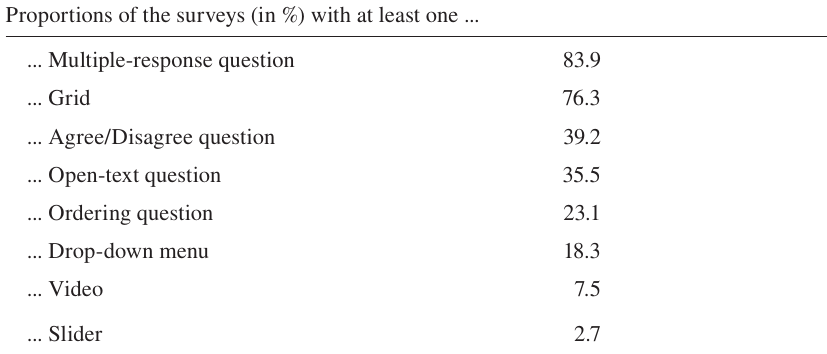
Table 5 Proportions of surveys including different questions formats Proportions of the surveys (in %) with at least one